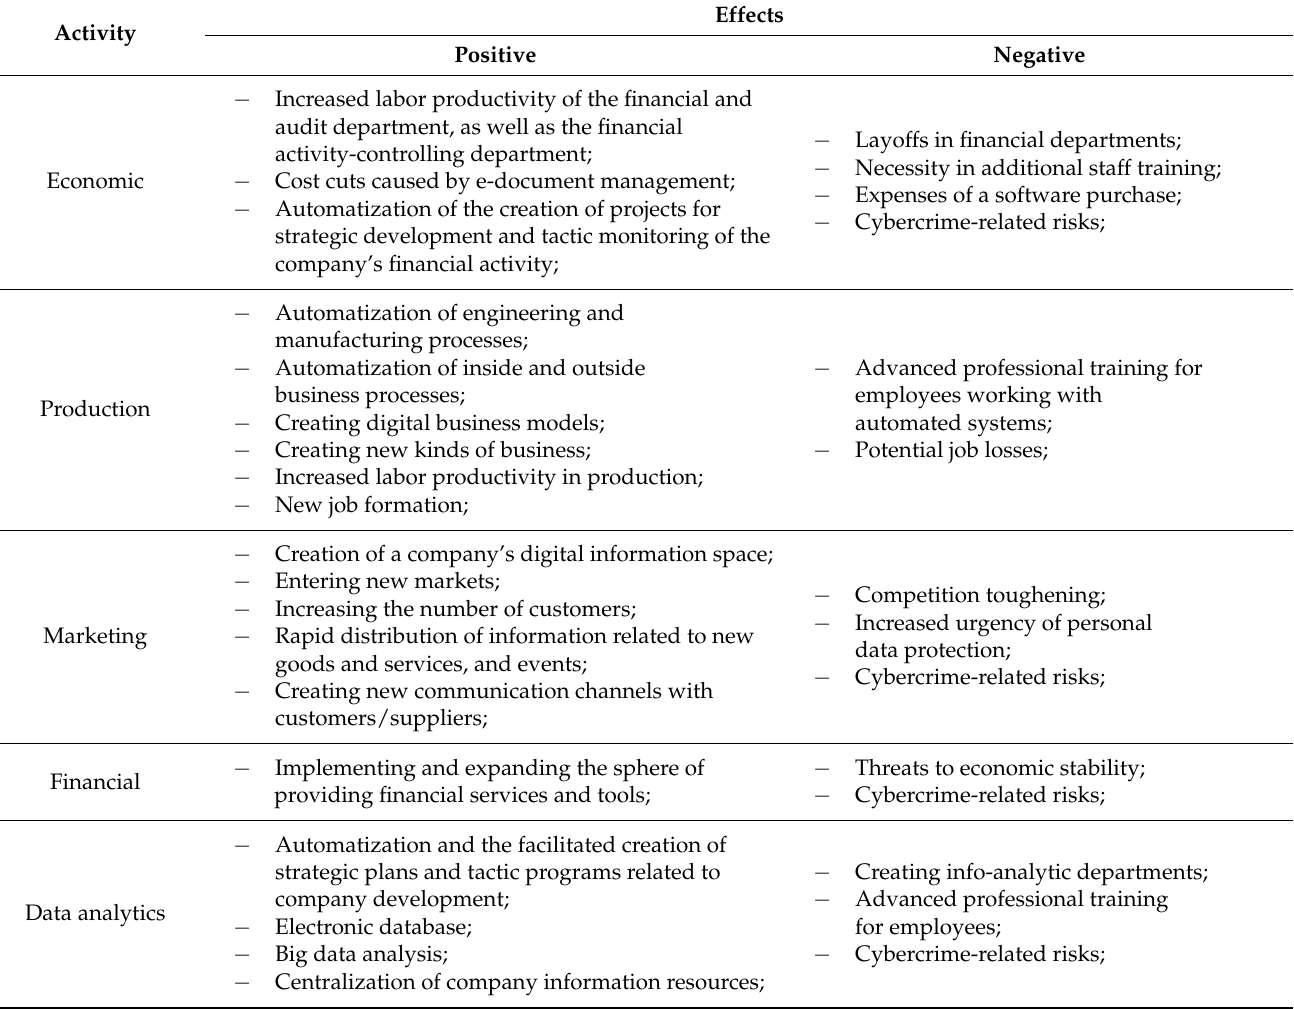
Table 1. Effects of digitalization on company activities in terms of financial